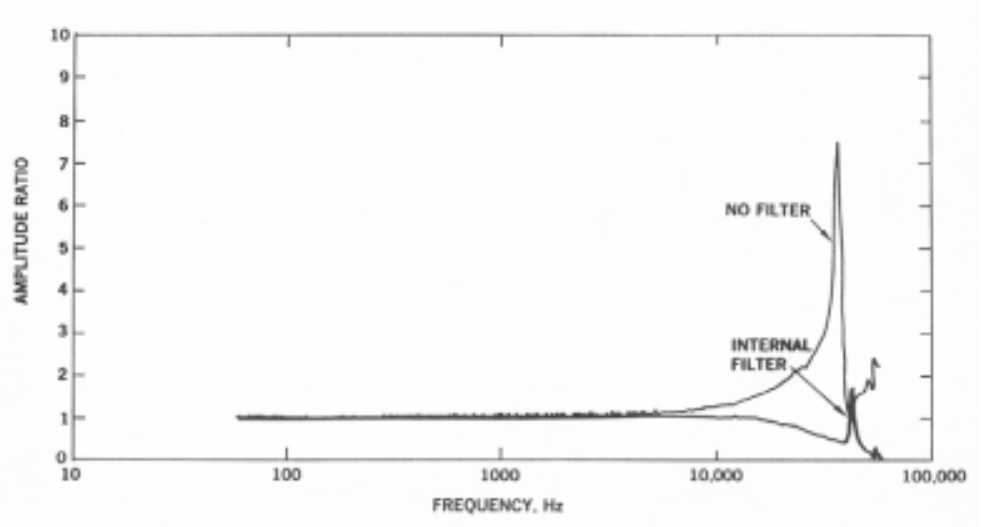
Fig. 10. Comparison of filtered and unfiltered PCB 305 types.